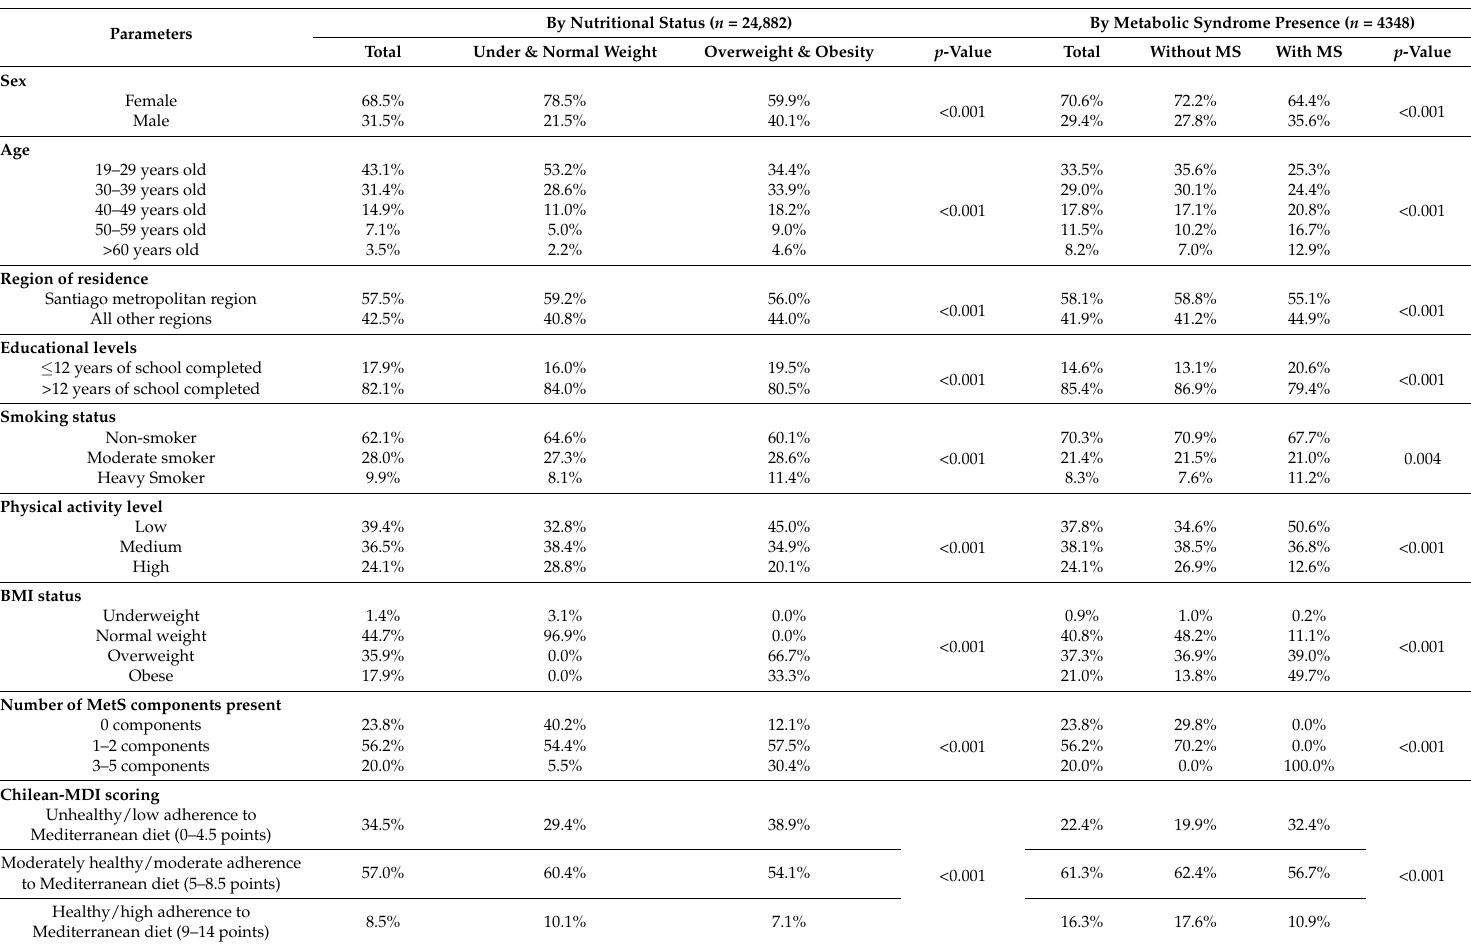
Table 2. Summary statistics of the self-selecting sample of Chilean adults shown by nutritional status and metabolic syndrome